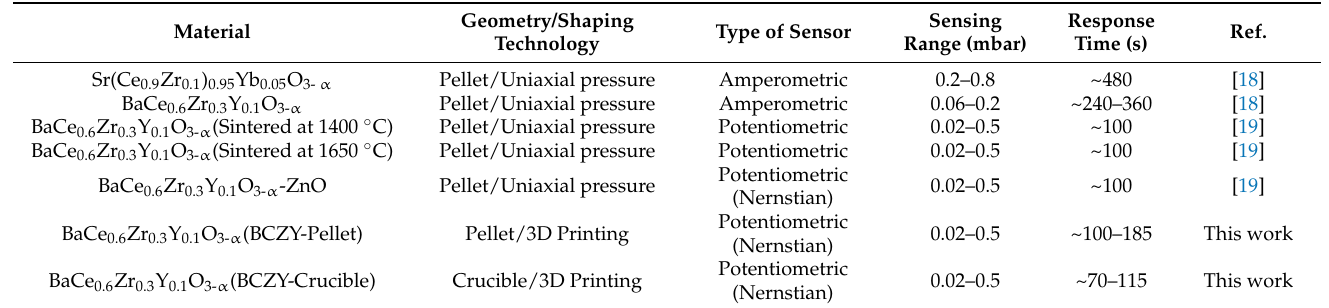
Table 4. Comparison of the analytical parameters of hydrogen sensors obtained in previous works with the sensors proposed in this